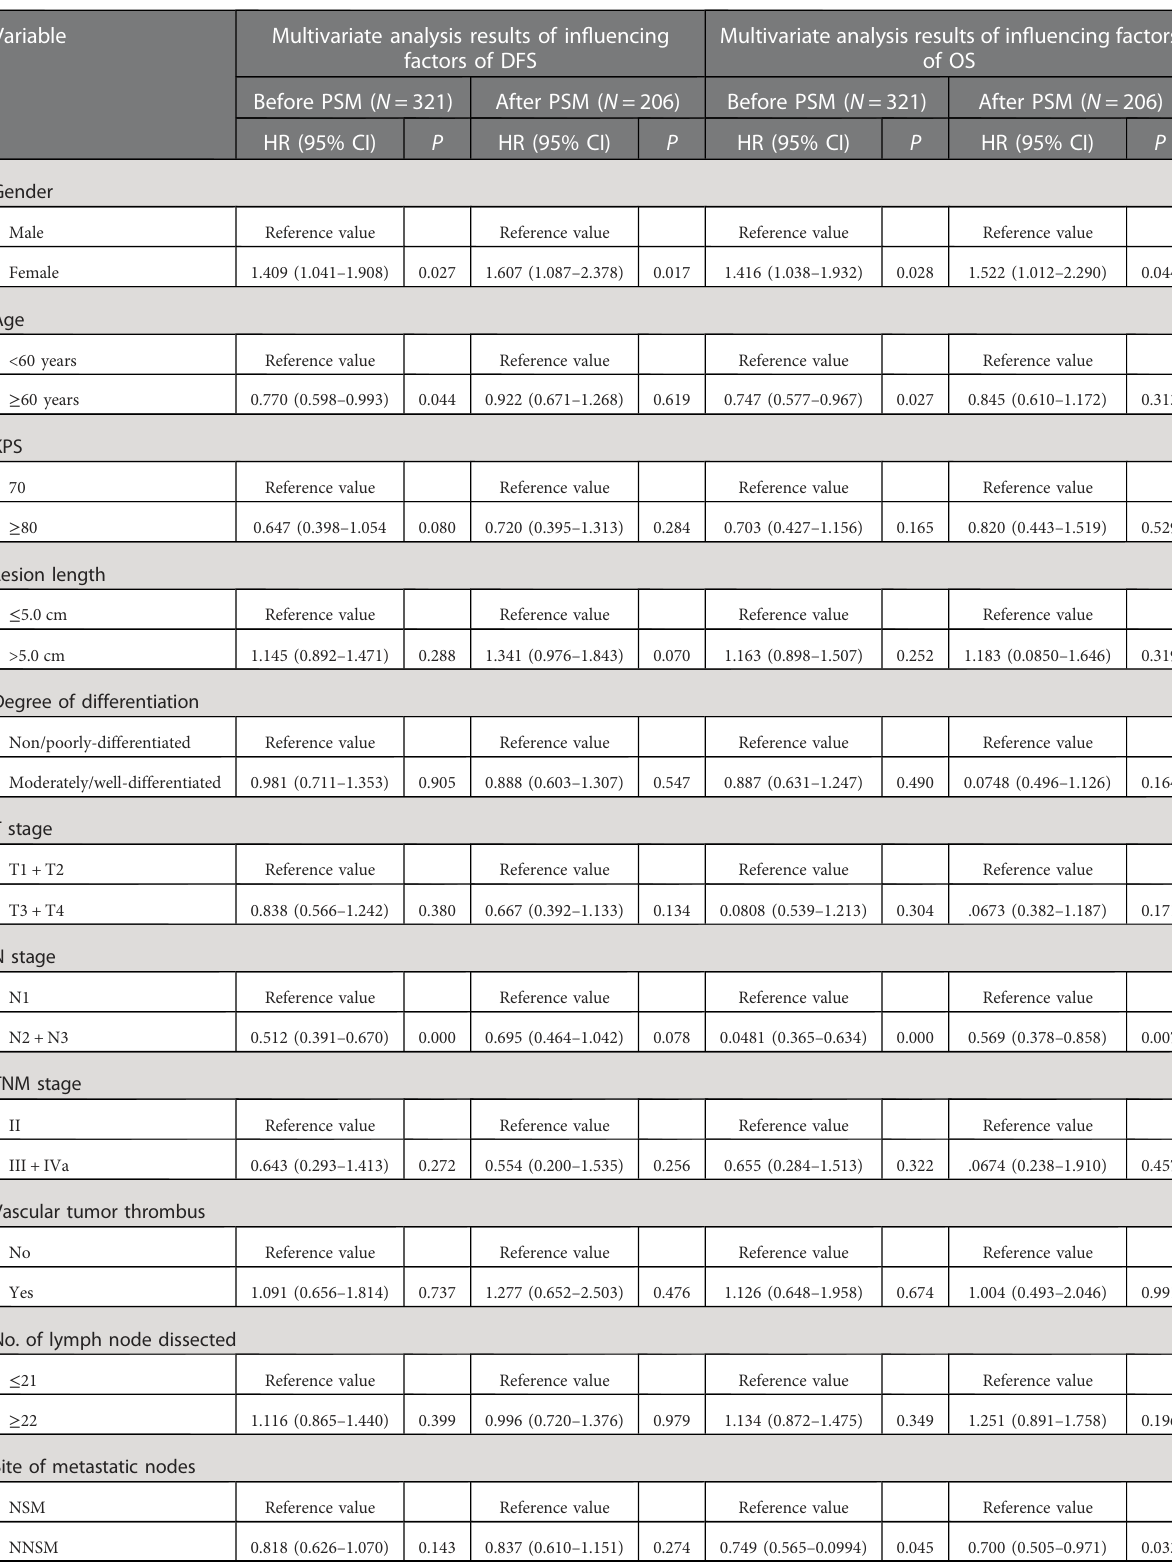
TABLE 5 Results of multivariate analysis of in fl uencing factors of OS and DFS of patients before and after